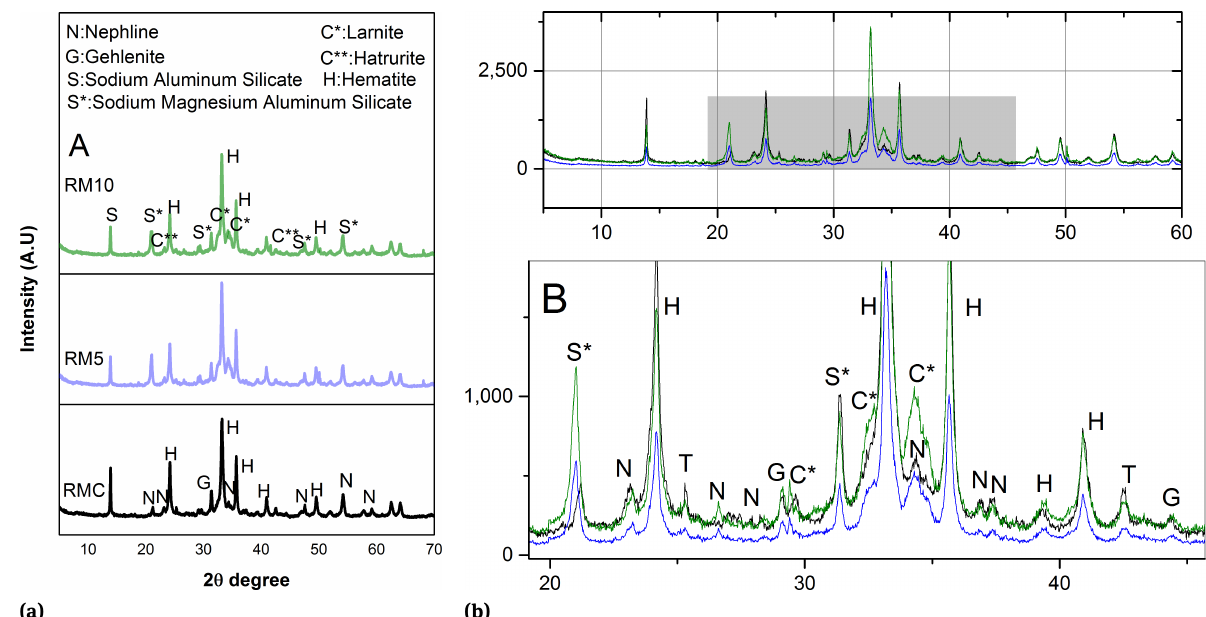
Figure 4: (A) XRD spectra for RMC, RM5 and RM10 samples calcined at 800 ∘ C; (B) Magnified XRD spectra for RMC, RM5 and RM10 sam- ples calcined at 800 ∘ C. (N:Nephline, G:Gehlinite, H:Hematite, T: Anatase, C*:Larnite, C**:Hatrurite, S: Sodium Magnesium Aluminum, S*:Sodium Magnesium Aluminum Silicate)